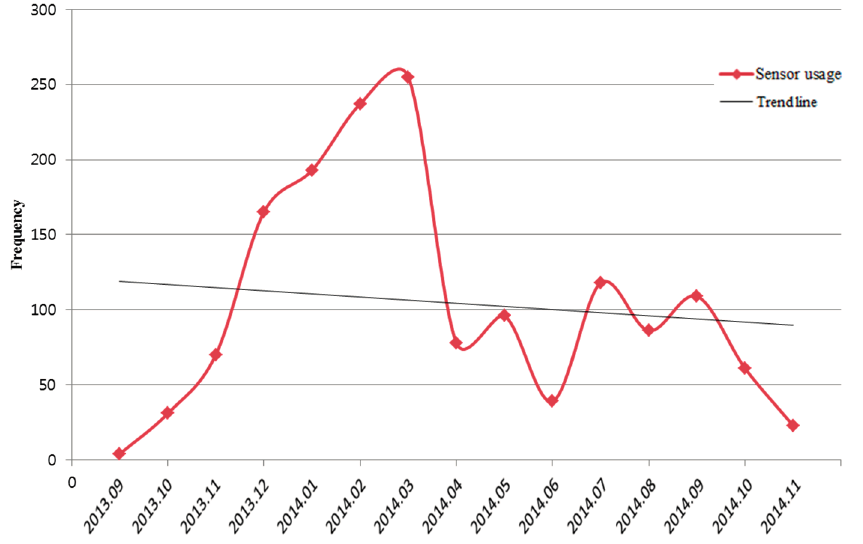
Figure 7. Usage pattern of Point-of-Care HIV check app by